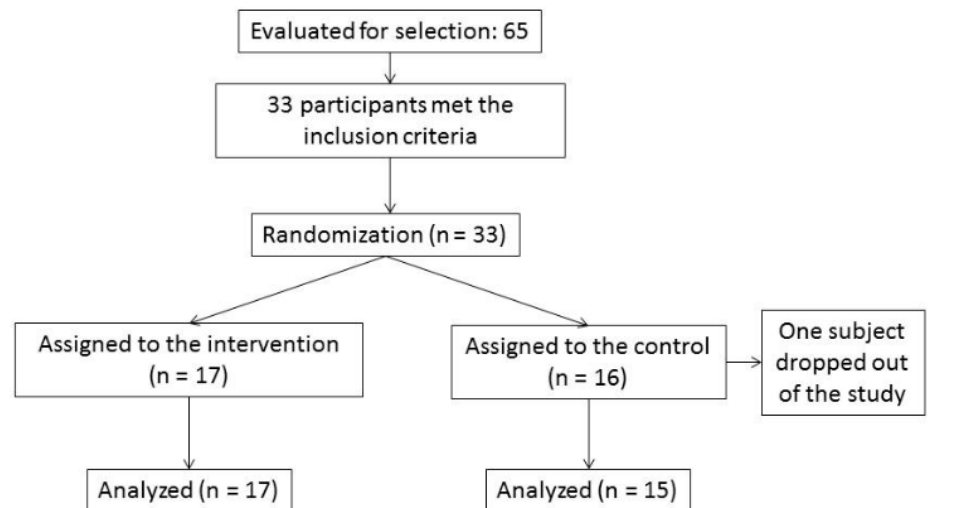
Figure 1. Flow of participants through the phases of a parallel randomized clinical trial of two groups.